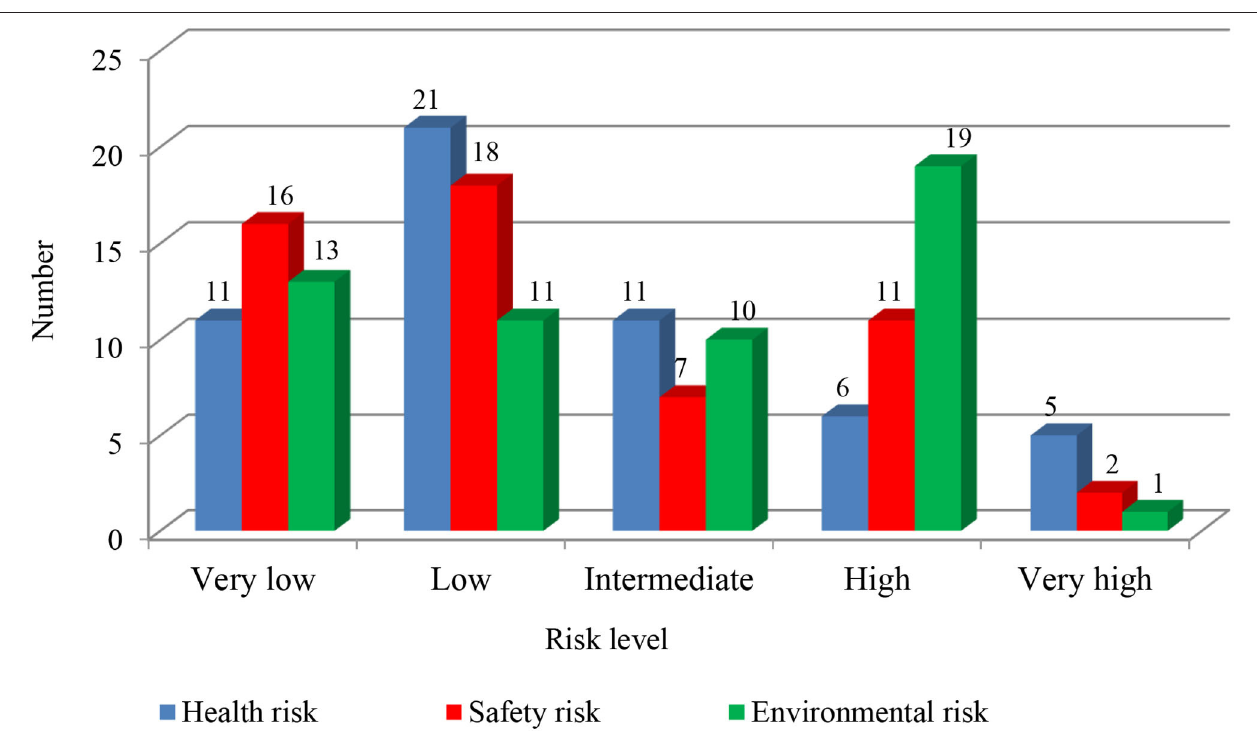
FIGURE 2 | Frequency of chemicals at estimated risk level classes in university laboratory